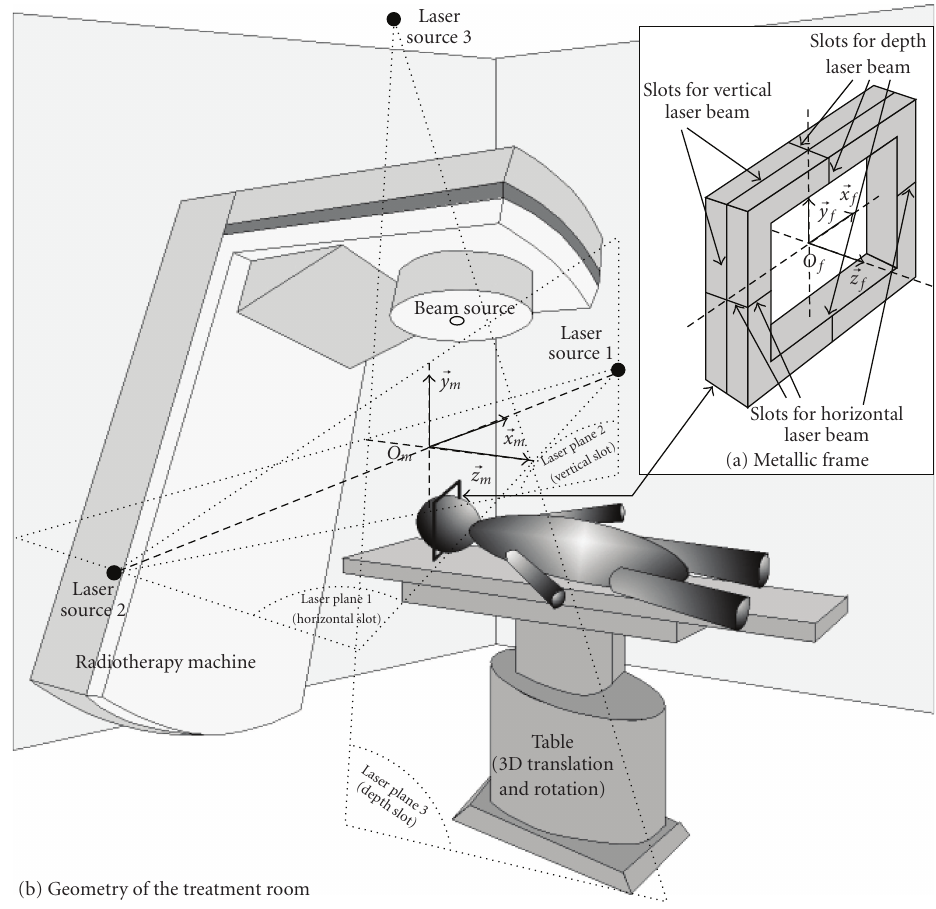
Figure 1: Principle of the frame-based method. (a) Geometry of the treatment room. (b) Frame geometry and coordinate system.